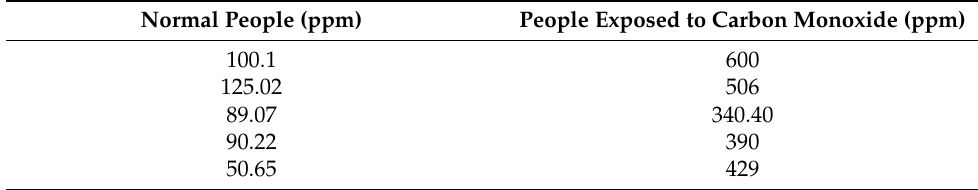
Table 8. Carbon monoxide levels for the experimental group.